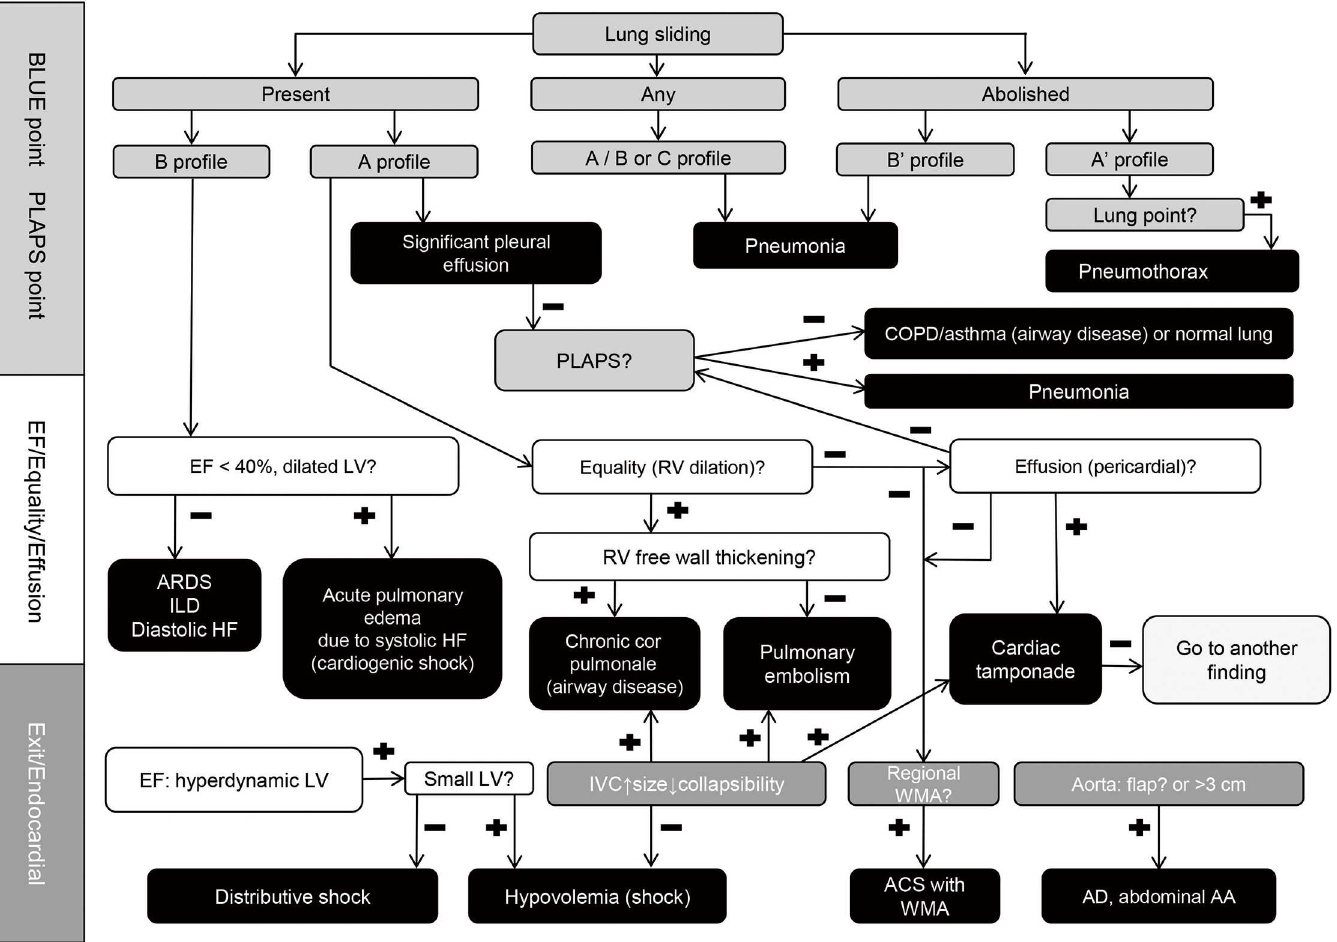
Fig 1. The algorithm for SEARCH 8Es. Profiles : A, lung slidingand A lines in both the lungs; A’, A profile without lung slidingand lung point; B, anterior- predominant bilateralB lines with lung sliding;B’, B profile without lung sliding; A/B, anterior-predominantB lines in one lung and predominantA lines in the other; C, anterior alveolarconsolidation(s). Abbreviations : AAA, abdominalaortic aneurysm; ACS, acute coronarysyndrome; AD, aortic dissection;ARDS, acute respiratory distress syndrome; BLUE, bedsidelung ultrasound in emergency; COPD, chronicobstructive pulmonary disease;EF, ejectionfraction; HF, heart failure; ILD, interstitial lung disease;IVC, inferior vena cava; LV, left ventricle; PLAPS, posterolateral alveolar/orpleuralsyndrome; RV, right ventricle; SEARCH, sonographicevaluation of aetiologyfor respiratory difficulty, chest pain, and/or hypotension; WMA, wall motion abnormality. https://doi.org/10.1371/journal.pone.0174581.g001 PLOS ONE | https://doi.org/10.1371/journal.pone.0174581 March 29,